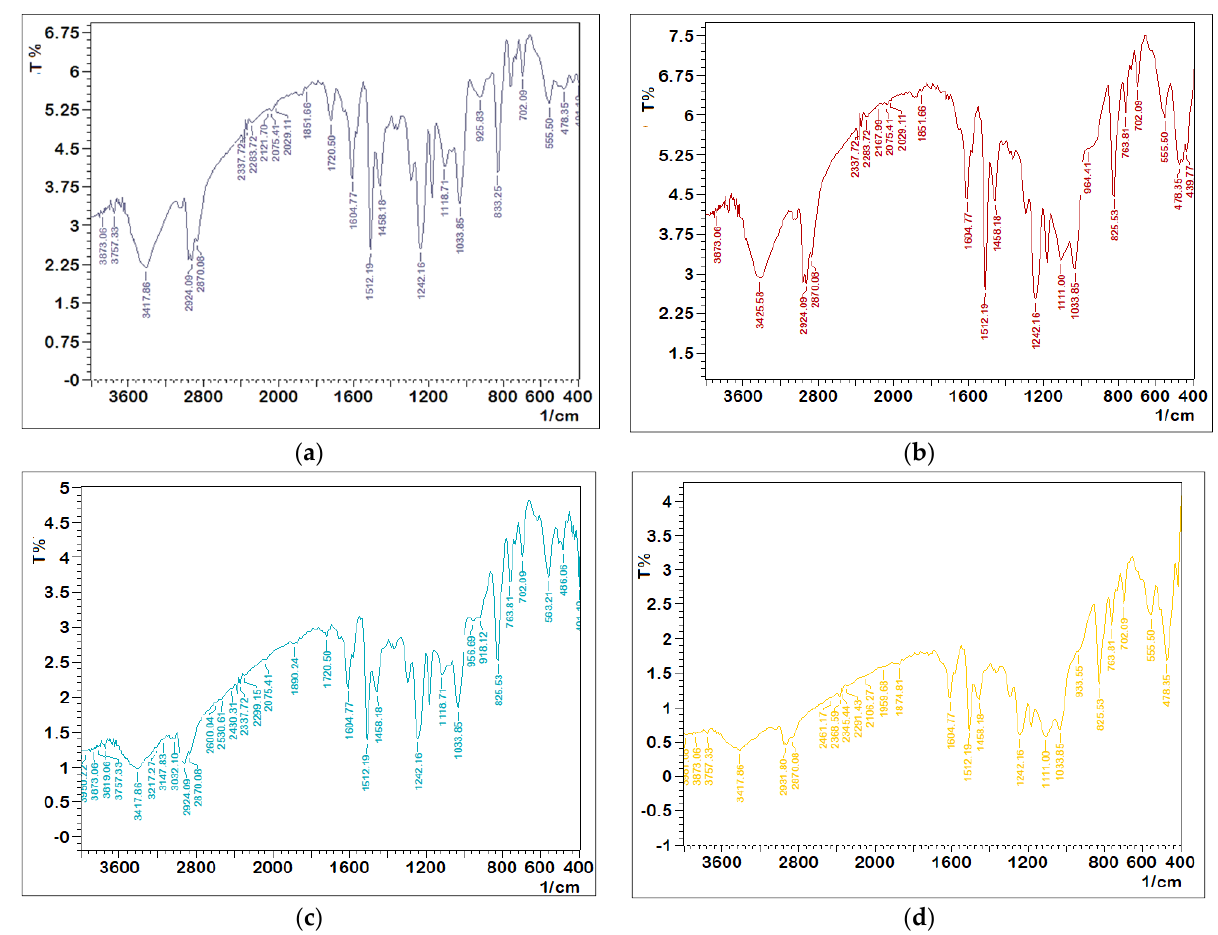
Figure 1. FTIR analysis: ( a ) neat epoxy, ( b ) 15% nanosilica, ( c ) 15% nanoglass, and ( d ) 15% nano–fly ash.